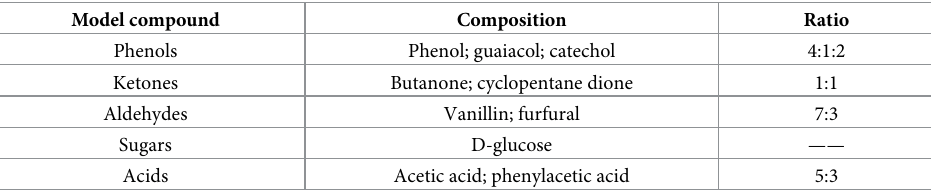
Table 2. Composition and ratio of bio-oil model